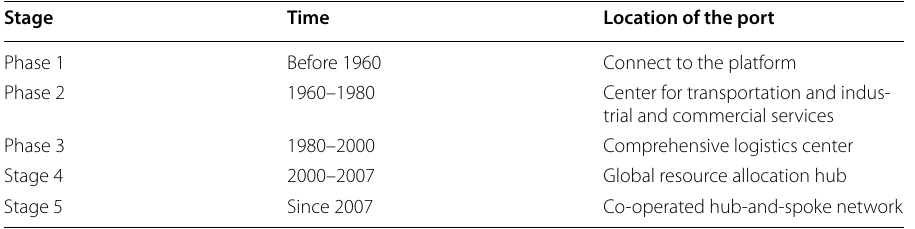
Table 1 Port evolution